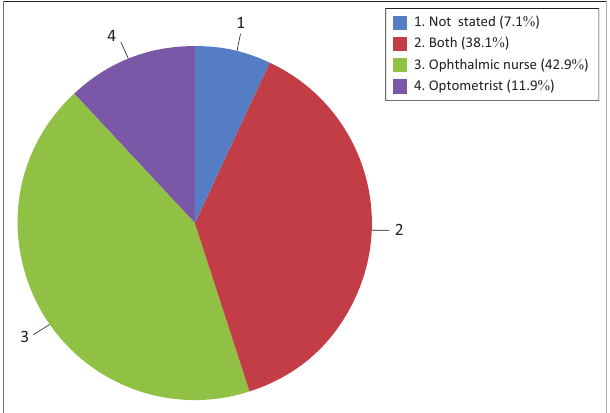
1. Not stated (7.1 % ) 2. Both (38.1 % )